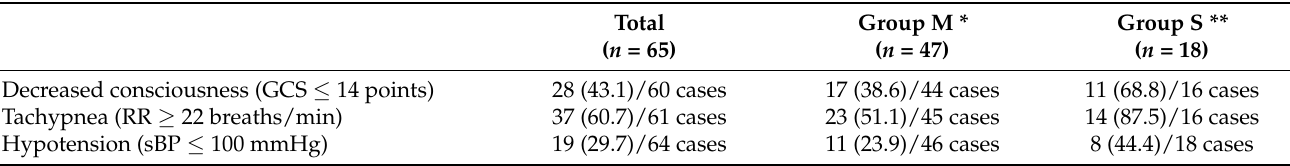
Table 5. Number of patients who matched the RRT request criteria.